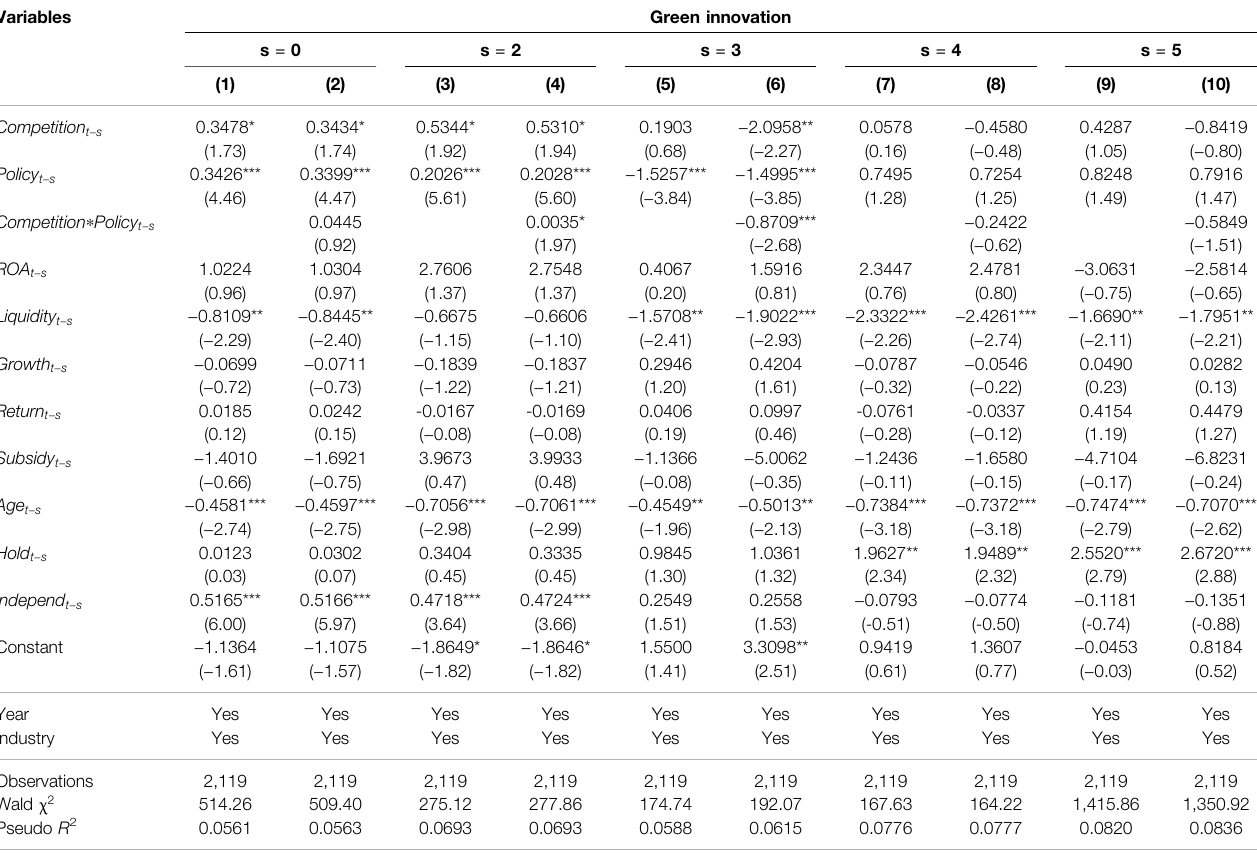
TABLE 9 | Results of robustness